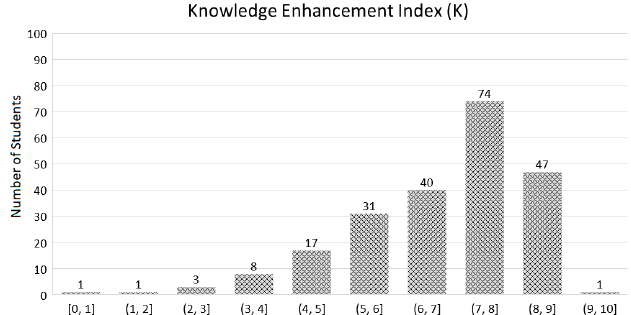
Figure 8. Knowledge Enhancement Index.